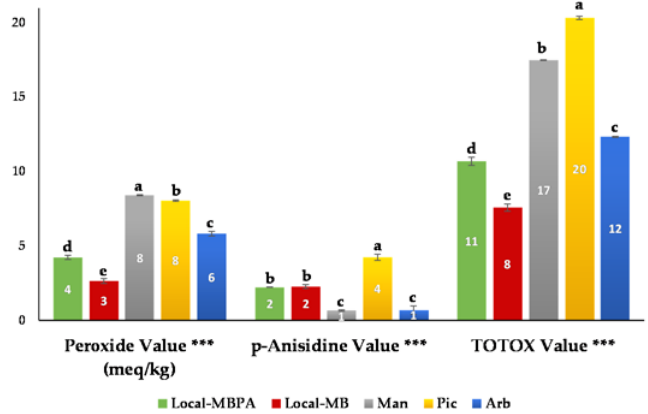
Figure 2. Lipid oxidation parameters of the VOOs. *** ( P ≤ 0.001). a–d Mean values in the same row with different letters indicate significant differences ( P < 0.05). Local ‐ MBPA (60% Mansa and Brava, 25% Picual, and 15% Arbequina); Local ‐ MB (60% Mansa and 40% Brava); Man (100% Mansa cultivar); Pic (100% Picual cultivar); Arb (100% Arbequina cultivar).